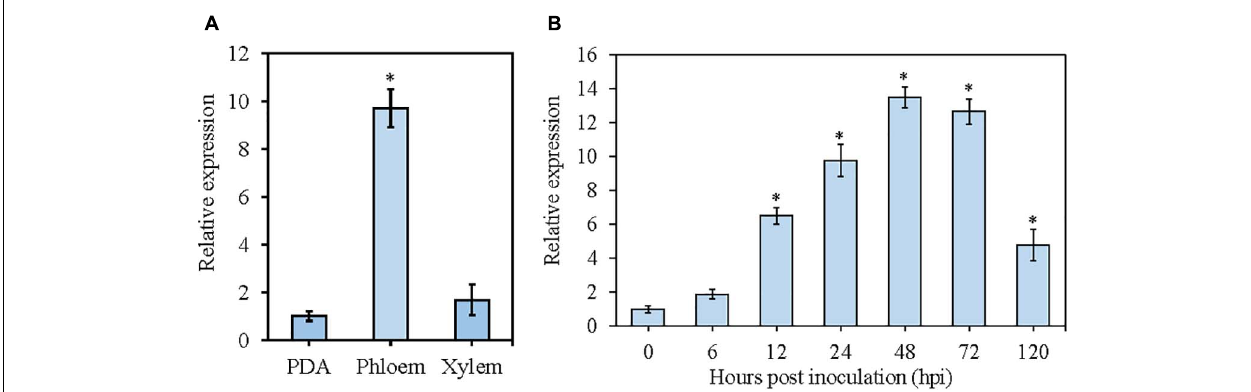
FIGURE 3 | The expression levels of VmGlu2 in different apple tissues at time points post-inoculation determined by qRT-PCR. The expression level of V. mali EF1-a gene was used as an endogenous control, and the means and standard deviation of the relative expression levels were calculated from three independent biological replicates. (A) Relative expression levels of VmGlu2 in different apple tissues at 72 hpi. The expression level of VmGlu2 in the mycelia grown on PDA was normalized to one. Asterisks represent significant differences ( P < 0.05) in expression levels relative to that in PDA. (B) Relative expression levels of VmGlu2 at 0, 6, 12, 24, 48, 72, and 120 hpi. Asterisks represent significant differences ( P < 0.05) in expression levels as compared to that at 0 hpi.